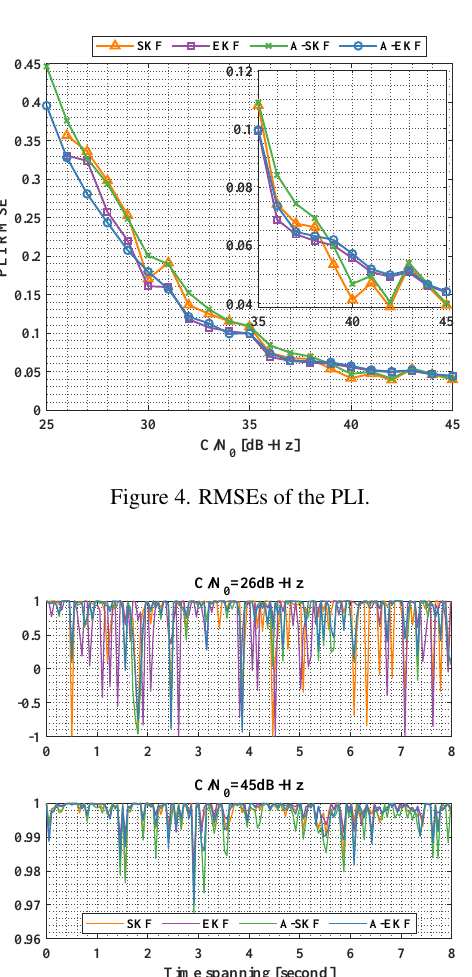
Figure 5. PLI estimation results.